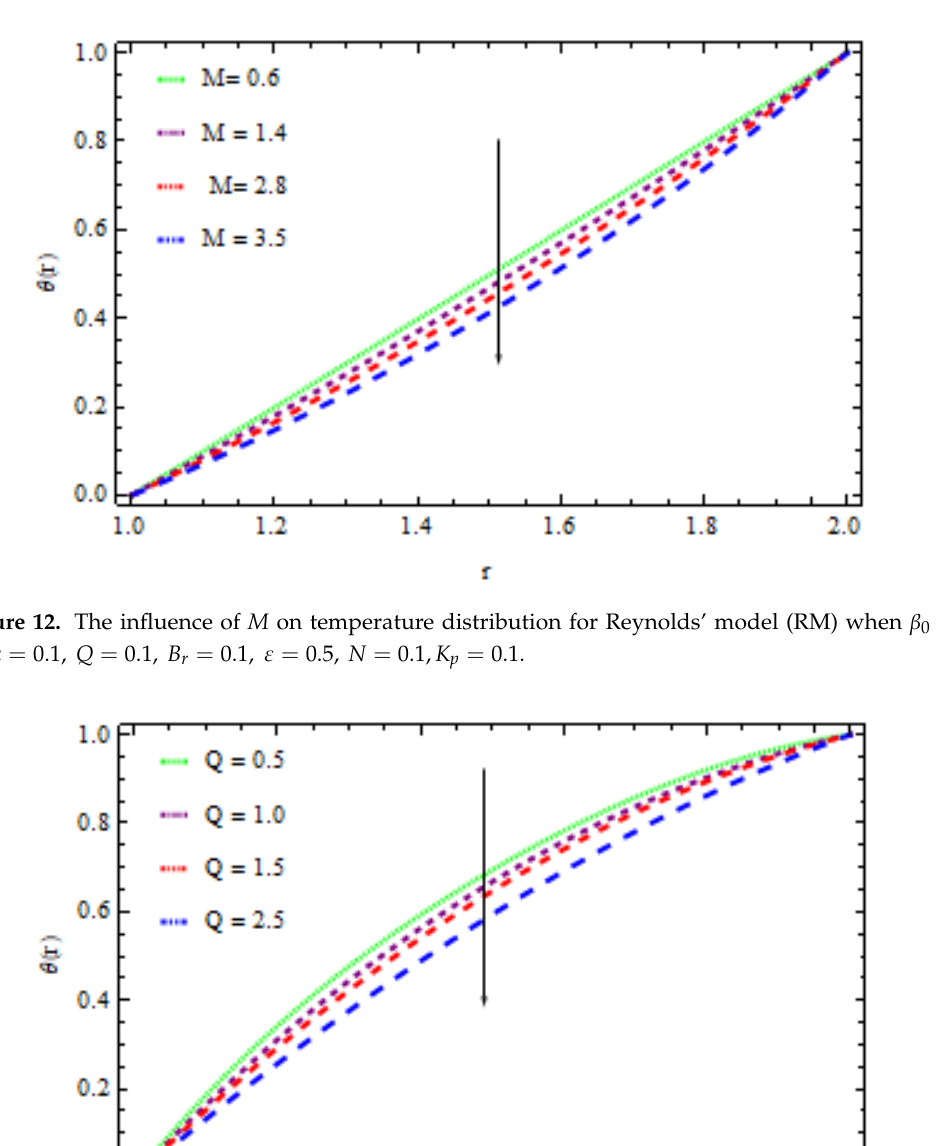
Figure 13. The influence of Q on temperature distribution in the case of Reynold’s model (RM) when β = 2.1, m = 0.2, ε = 0.2, B r = 0.5, M = 0.6, N = 0.2, K p = 0